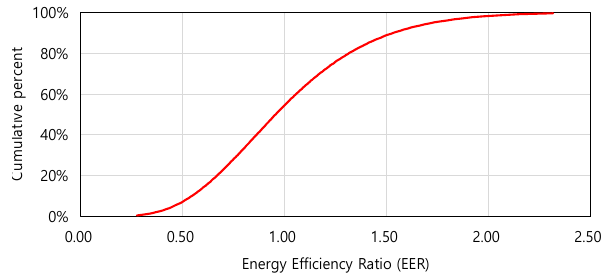
Figure 4. Gamma distribution according to the EER calculation result of office buildings. Table 9. Look-up table based on EER calculation result.